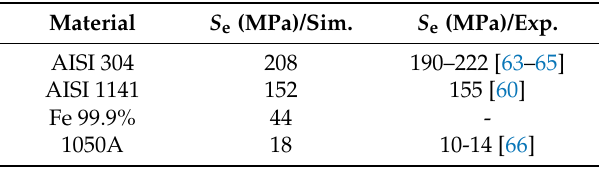
Table 4. Fatigue limits of the investigated materials.